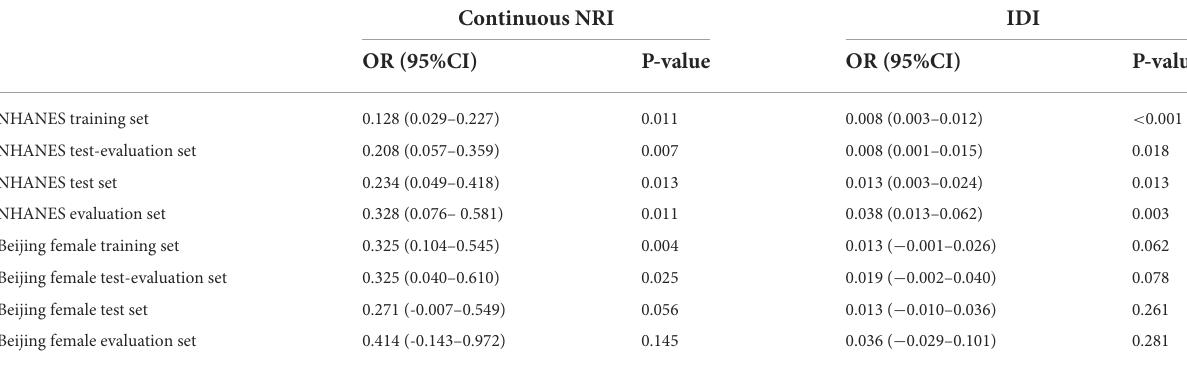
TABLE 1 NRI and IDI of the Modelbest-developed models for predicting HPV infection than models developed on multivariate logistic